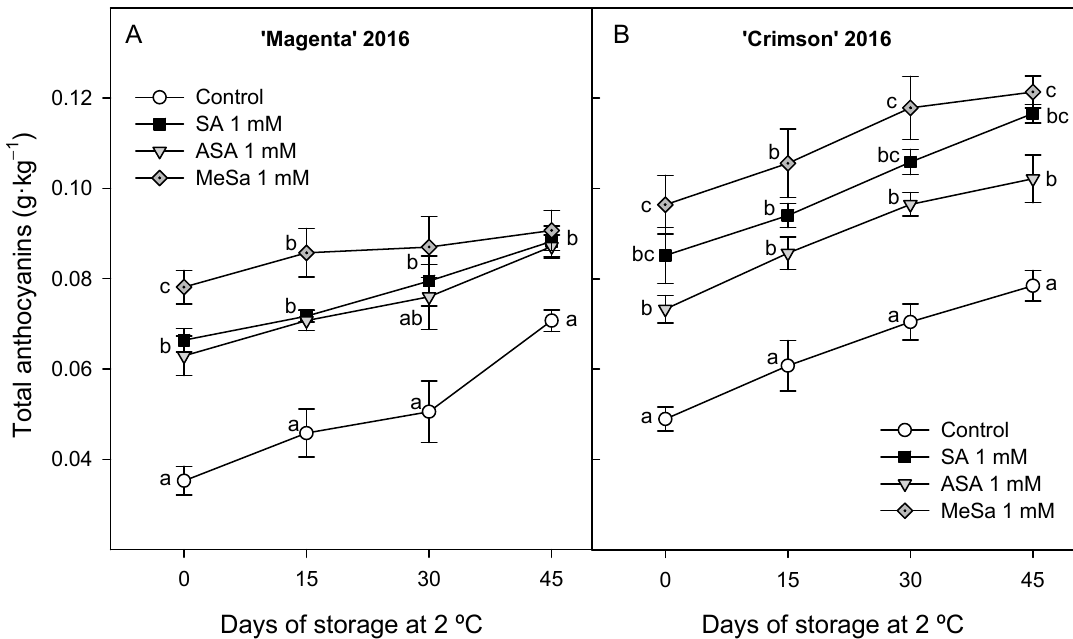
Figure 1. Effects of preharvest 1 mM salicylic acid (SA), acetyl salicylic acid (ASA) and methyl salicylate (MeSa) treatments on total anthocyanin concentration on ‘Magenta’ ( A ) and ‘Crimson’ ( B ) cultivars during storage at 2 °C in 2016 experiment. Data are the mean ± SE of quantifications made in duplicate in three replicates. Different letters show significant differences ( p < 0.05) among treatments for each sampling date.